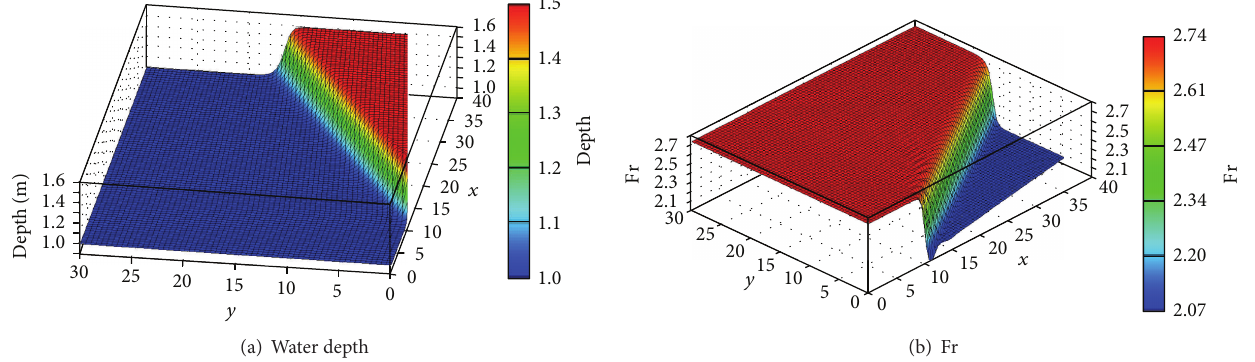
Figure 13: Formation of water depth and Froude number after oblique hydraulic jump.